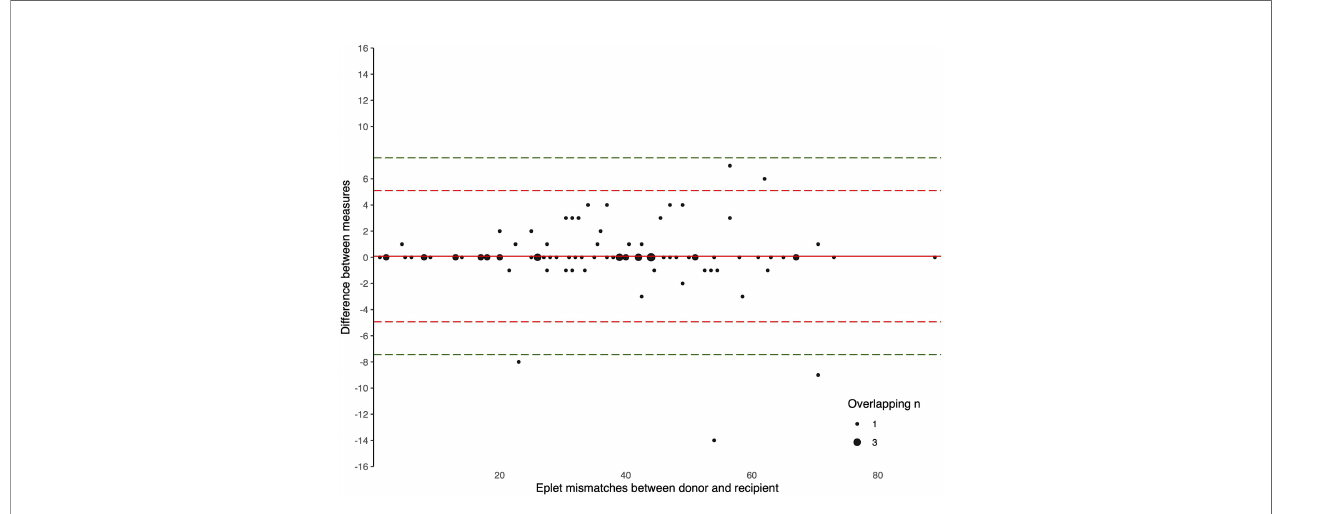
FIGURE 2 | Bland Altman Plot – total HLA class II eplet mismatches. A positive result indicates a greater number of eplet mismatches identi fi ed by NGS-typing compared to LD-typing. The red and green dashed lines represent 2 and 3 standard deviations from mean